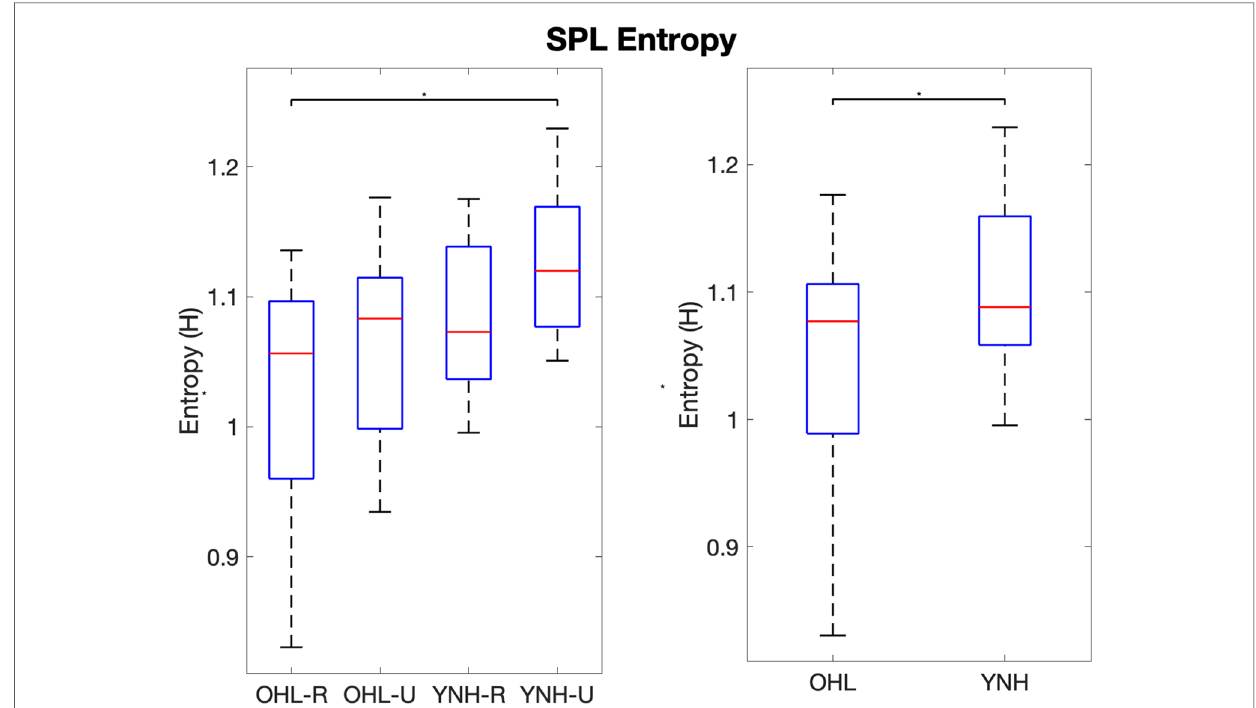
FIGURE 2 Boxplots of SPL entropy values per group (left) and groups combined along age and hearing status (right). OHL-R, older hearing loss rural; OHL-U, older hearing loss urban; YNH-R, younger normal hearing rural; YNH-U, younger normal hearing urban. OHL, older hearing loss (rural and urban combined); YNH, younger normal hearing (rural and urban combined). Vertical bars represent values within the fi rst and third quartiles þ = (cid:2) the interquartile range (cid:3) 1.5. Dots represent outliers. * indicates p , 0 :